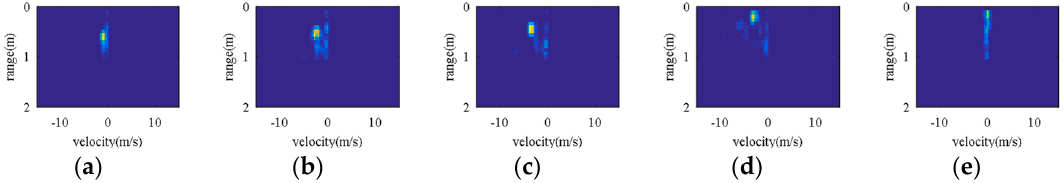
Figure 12. Improved RDMs with windowing and IF-BPF of a push hand gesture. ( a ) Improved RDM of frame 1. ( b ) Improved RDM of frame 7. ( c ) Improved RDM of frame 12. ( d ) Improved RDM of frame 22. ( e ) Improved RDM of frame 28.